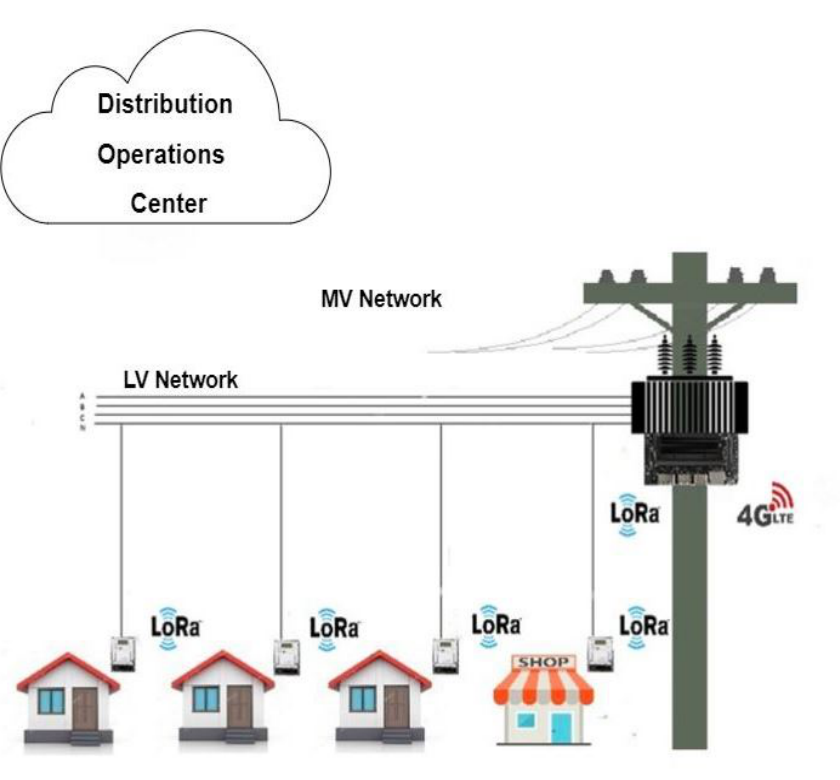
Figure 1. Decentralised